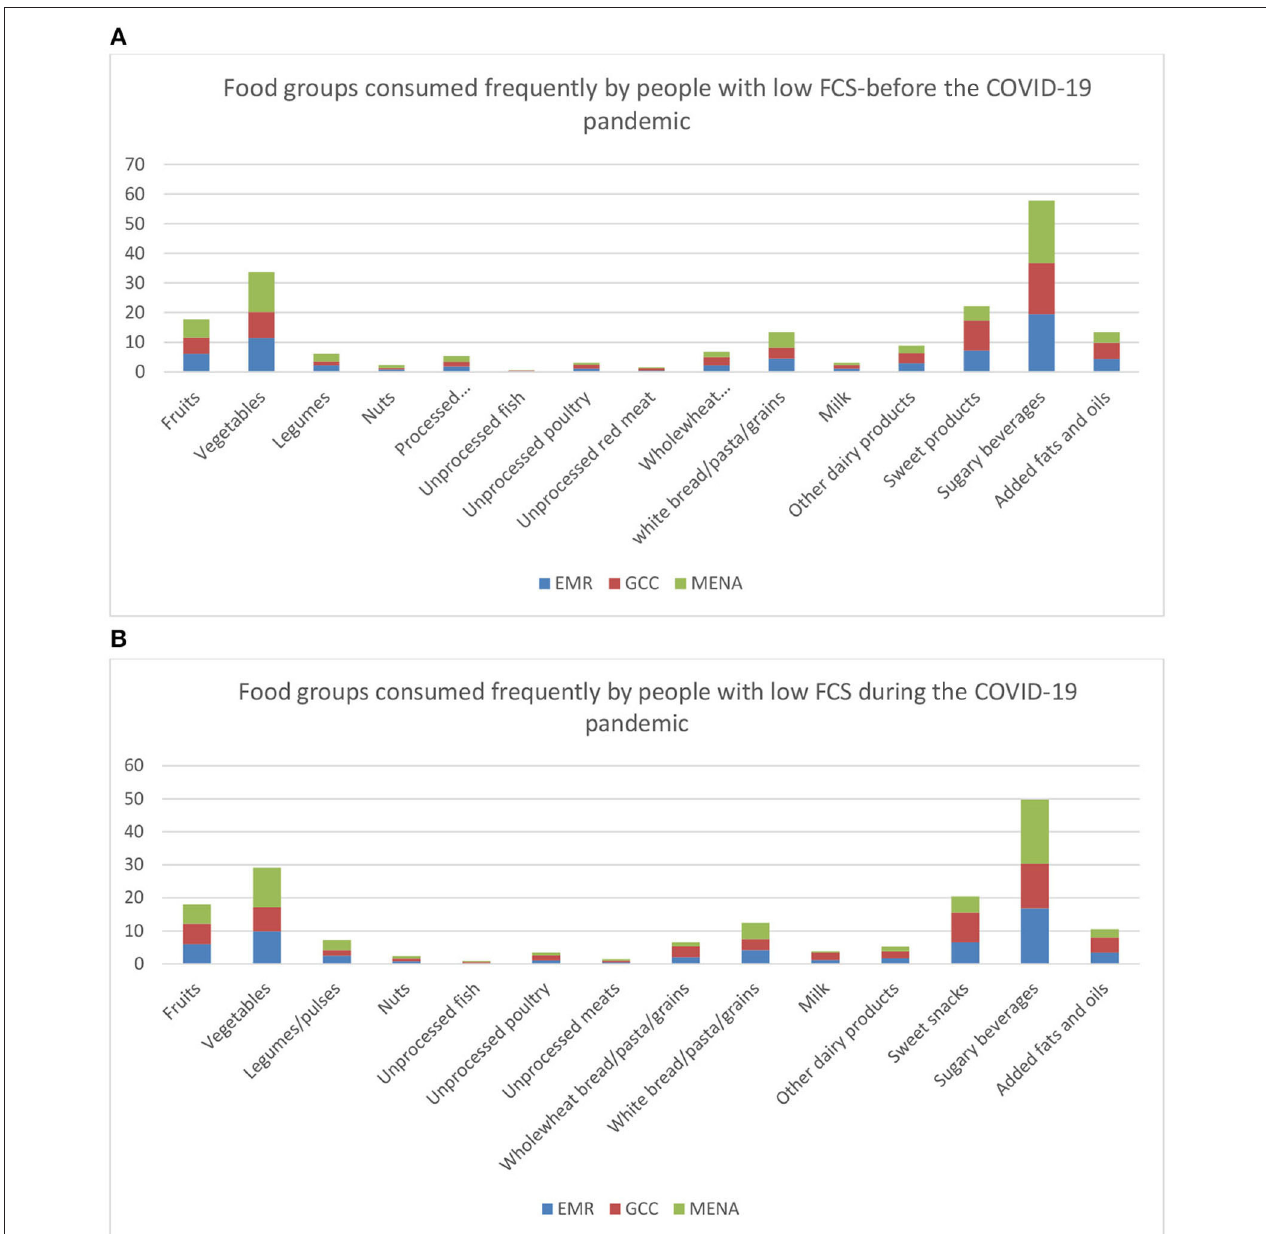
FIGURE 1 | (A) Food groups consumed frequently by people having low FCS in the EM countries prior to the pandemic. (B) Food groups consumed frequently by people having low FCS in the EM countries during the pandemic. remained unchanged in the GCC countries ( p -value = 0.08). The The Food Consumption Score was calculated based on lowest FCS values were observed in the MENA countries: Jordan, the equation explained previously. Compared to the period Lebanon, and Palestine ( Table 5 ). The percentage of people preceding the pandemic, the mean levels, and SD of the FCS in all having low FCS ( < 42) increased from 9.3 to 11.4% in the overall the countries studied was equal to 100.3 ± 45.9 and it remained EM countries studied during the lockdown. Moreover, in the unchanged during the pandemic ( p -value = 0.13). Before the GCC and the MENA countries, the percentage of people having pandemic, the FCS in the GCC countries (104.8 ± 46.7) was low FCS increased from to 8% to 9.3% and from 10.8 to 13.6%, higher than that of the MENA countries (95.5 ± 44.7) ( p -value = 0.000). However, during the pandemic, the FCS declined in respectively ( p -value = 0.00 and p -value = 0.00, respectively). the MENA countries from 95.5 to 93.9 ( p -value = 0.00) but The percentage of people with high FCS decreased of 3%